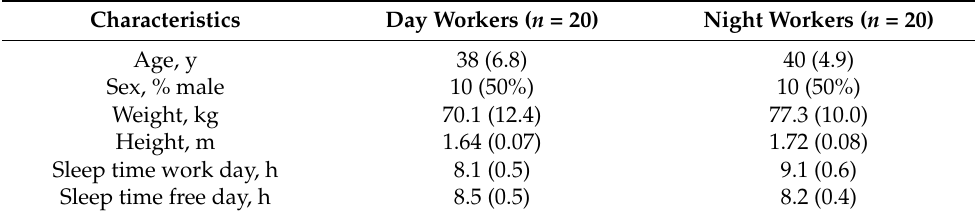
Table 1. Baseline characteristics of the